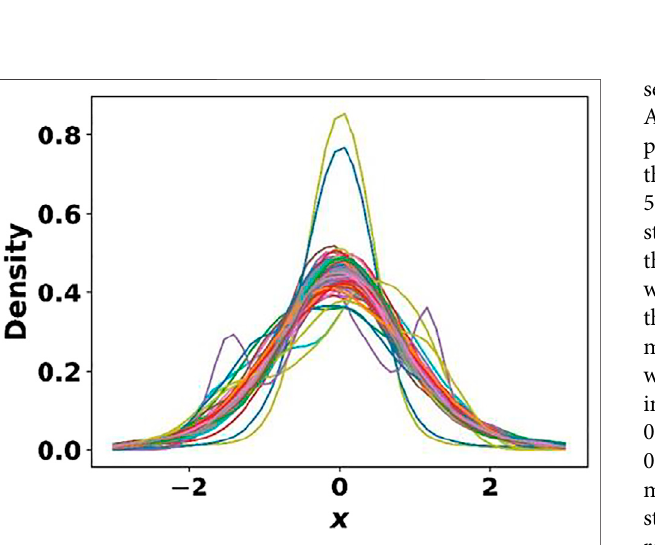
FIGURE 8 | Kernel density estimate plot for the 128-dimensional CVAE latent space. The learned latent space was mostly smooth and continuous and approximately followed a unit Gaussian.